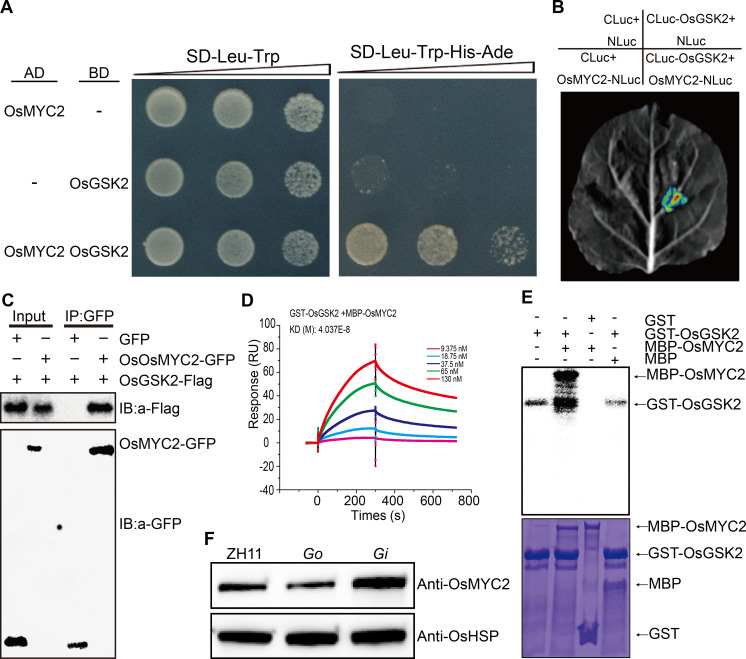
OsGSK2 interacts with and phosphorylates OsMYC2.(A) Interaction between OsGSK2 and OsMYC2 detected in the yeast two-hybrid system. (B) Interaction between OsGSK2 and OsMYC2 detected by Luciferase Complementation Imaging (LCI) assay in Nicotiana benthamiana. (C) Interaction between OsGSK2 and OsMYC2 detected by Co-IP assays in Nicotiana benthamiana. (D) Interaction between OsGSK2 and OsMYC2 detected by physicochemical analysis. The affinity between GST-OsGSK2 and MBP-OsMYC2 was revealed by dissociation rate constant (KD) (dissociation rate / association rate). (E) In vitro phosphorylation assays of GST-OsGSK2 and MBP-OsMYC2. Phosphorylated proteins were detected by autoradiography (top). The proteins used for the phosphorylation assay are shown in the corresponding lower panels with Coomassie blue staining (CBS) (bottom). (F) OsMYC2 protein levels in 14-day seedlings of Go, Gi and the wild-type Zhonghua11 (ZH11) infested with RSV-carrying SBPH. OsHSP indicates loading control.